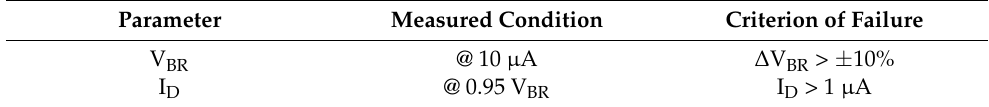
Table 1. The failure criteria of the tested APDs.